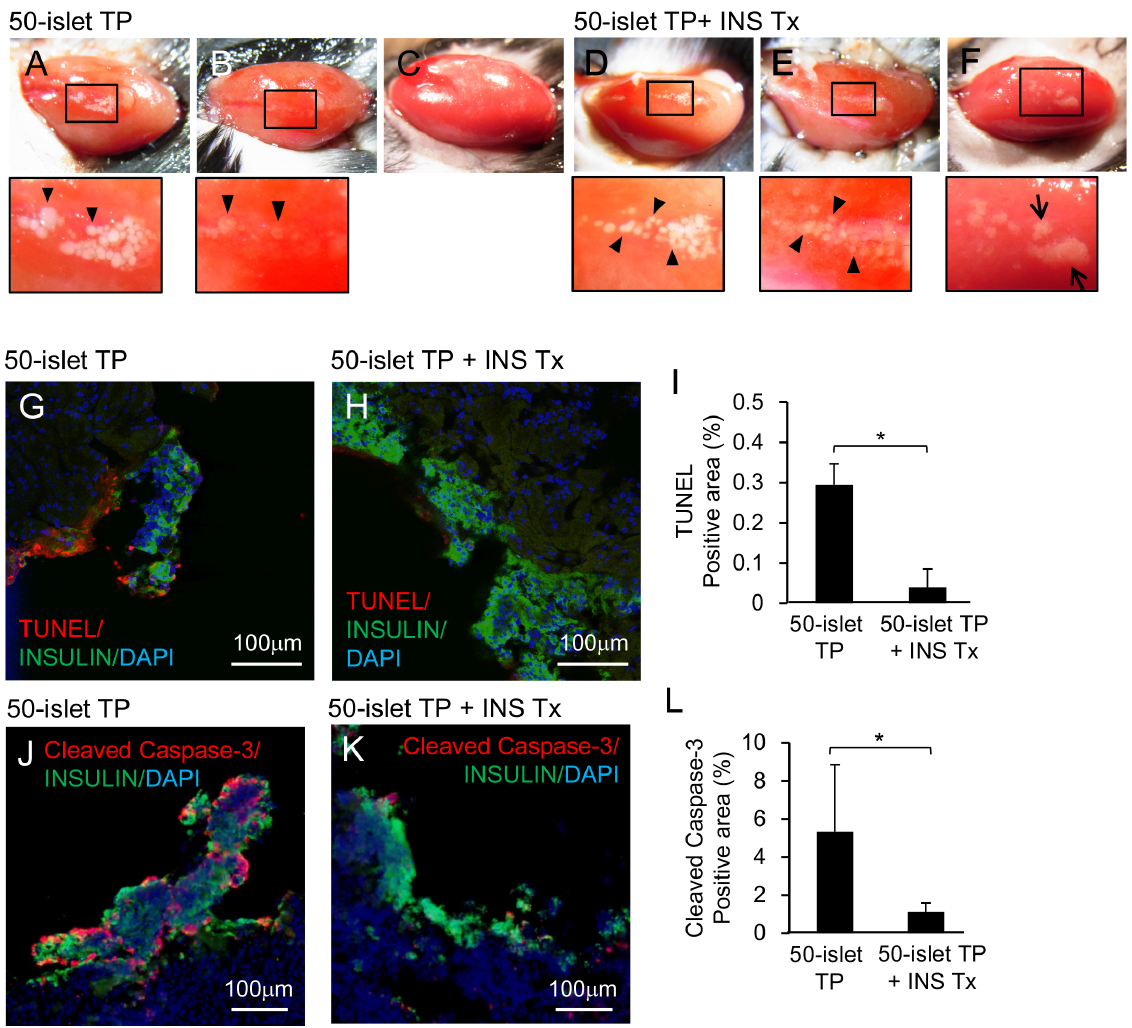
Figure 5. Graft survival improved as a result of insulin treatment. Kidneys from mice in the 50-islet TP group at (A) the time of transplantation, (B) day 1, and (C) week 18. (A) and (B) are from the same mouse. Kidneys from mice in the 50-islet TP + INS Tx group at (D) the time of transplantation, (E) day 1, and (F) week 18. (D) and (E) are from the same mouse. Lower panels show high-magnification images. Arrowheads indicate each islet, and arrows show aggregated islets. (G–L) Grafts were removed 6 hours post-transplantation and analyzed by TUNEL assay (G–I) or stained with anti-cleaved caspase-3 (J–L). Grafts of the 50-islet TP and 50-islet TP + INS Tx groups were compared (* p , 0.05, two-tailed unpaired Student’s t- test). (I, L) Proportions of the number of positive cells to total cells in the grafts. DAPI (blue), insulin (green), and TUNEL or anti-cleaved caspase-3